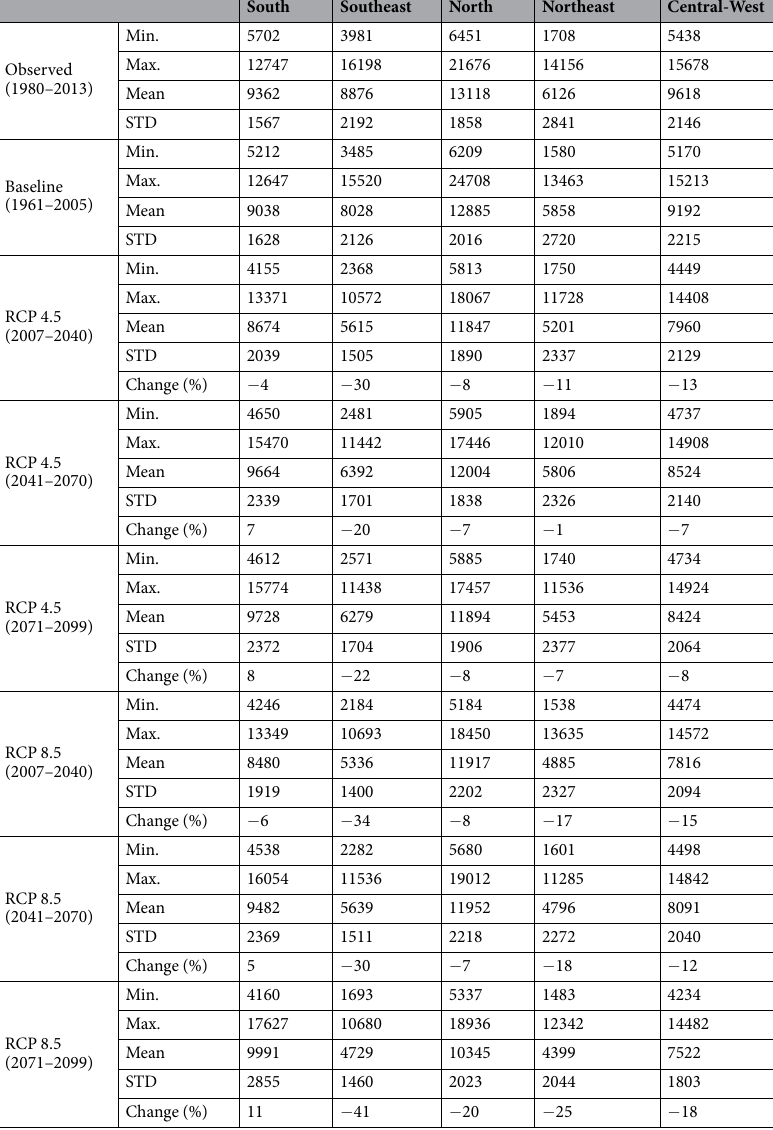
Table 1. Basic statistics of rainfall erosivity in Brazilian regions. Observed and estimated by HadGEM2-ES model. Minimum, maximum, mean, standard deviation (MJ mm ha − 1 h − 1 year − 1 ) and projected change in relation to baseline